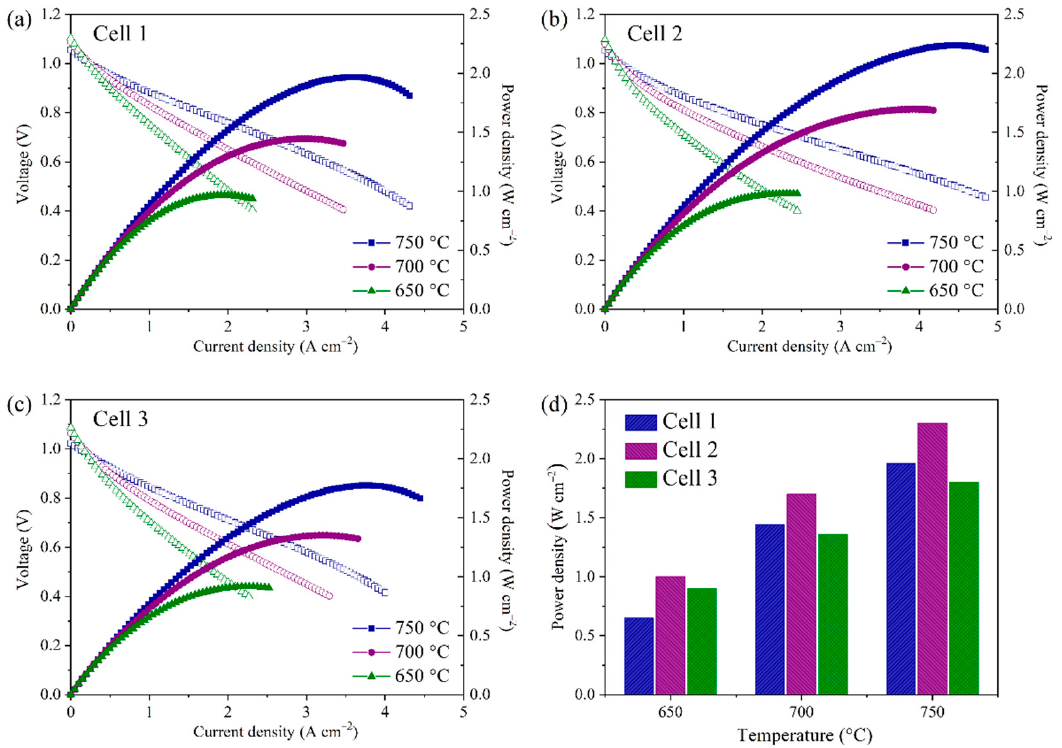
Figure 7. I-V and I-P curves for the single cells measured at different temperatures. ( a ) Cell 1, ( b ) Cell 2, ( c ) Cell 3, and ( d ) a comparison of peak power densities of three cells at the operating temperatures. Table 2. Comparison of the electrochemical performance of various SOFCs. Cell Composition Temp. (°C)